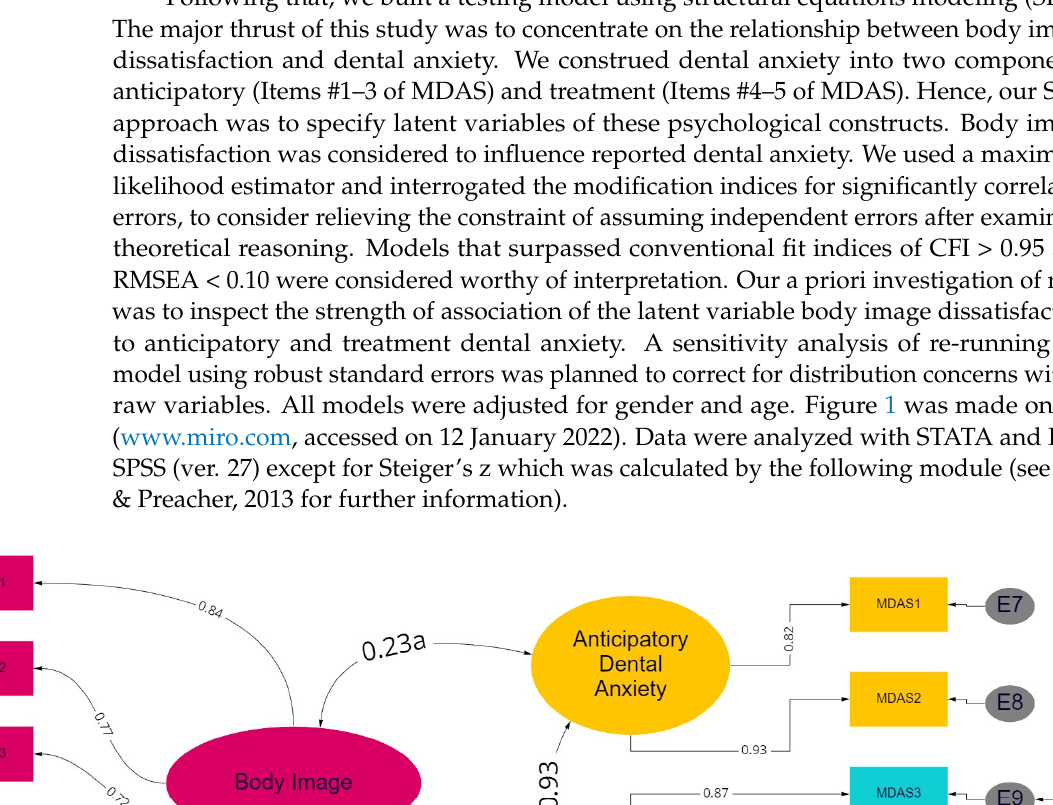
Table 3. Table of parameters (standardized) for full SEM.